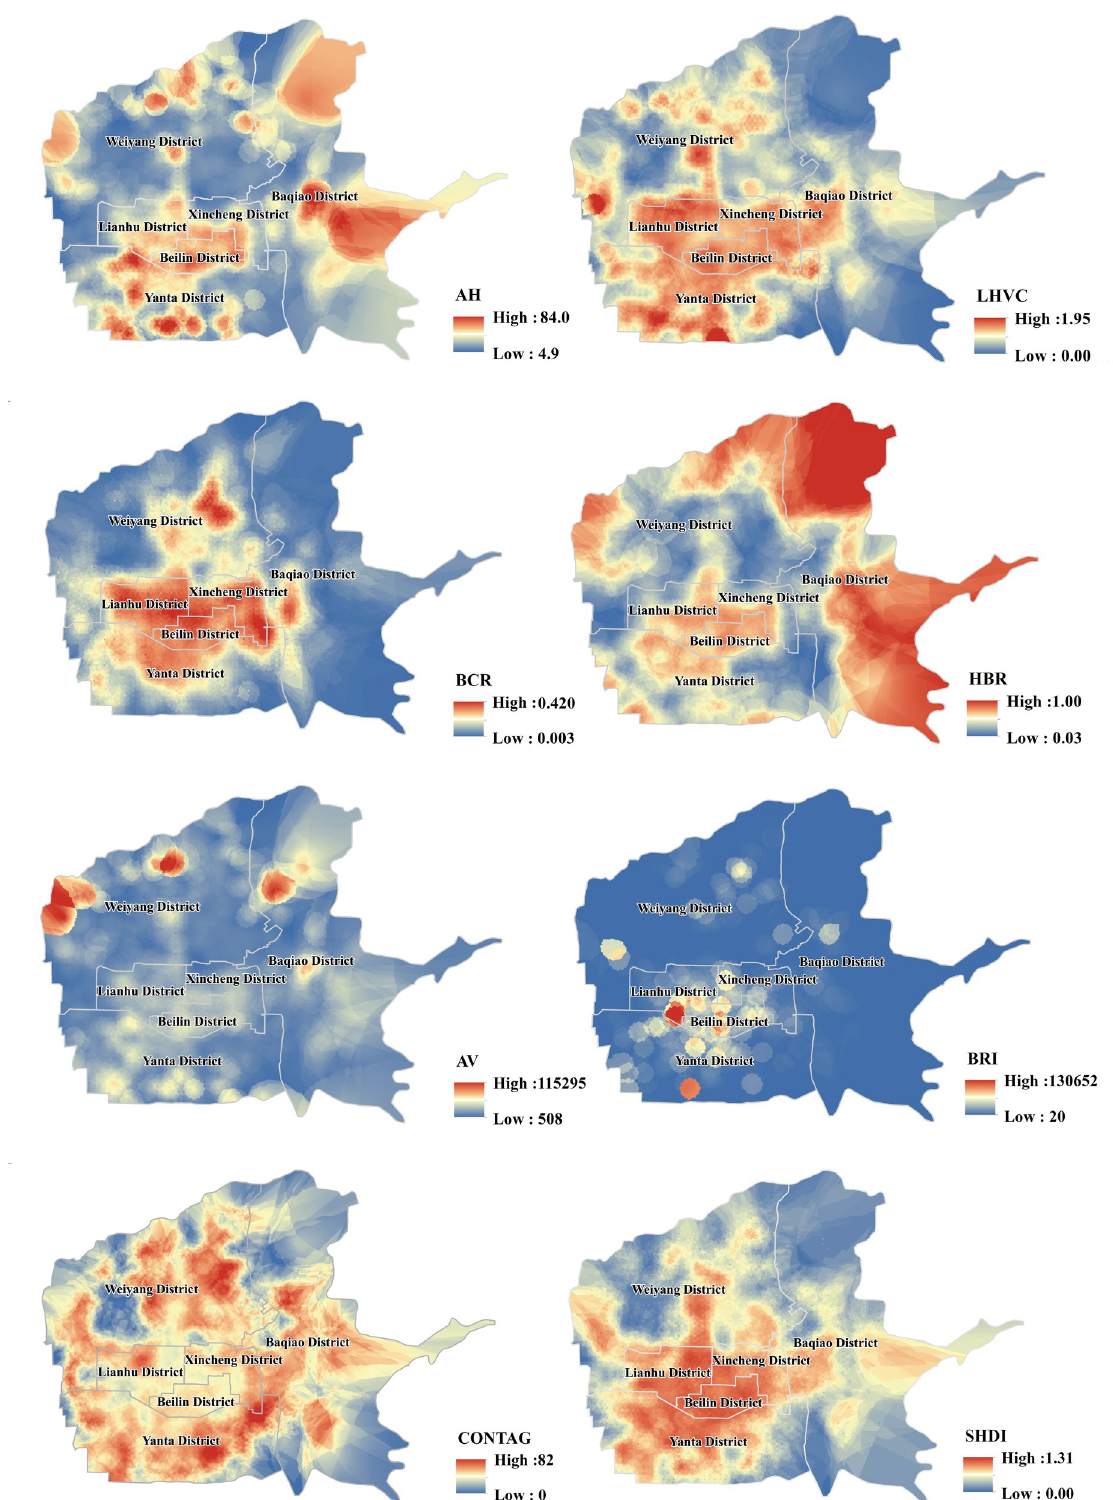
Fig 9. Spatial distribution map of architectural landscape pattern metrics. The map images are from the National Catalogue service for Geographic Information: http://www.ngcc.cn/.